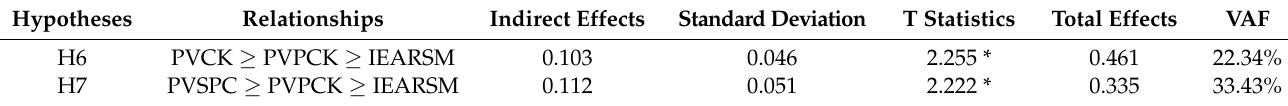
Table 6. The results for the structural